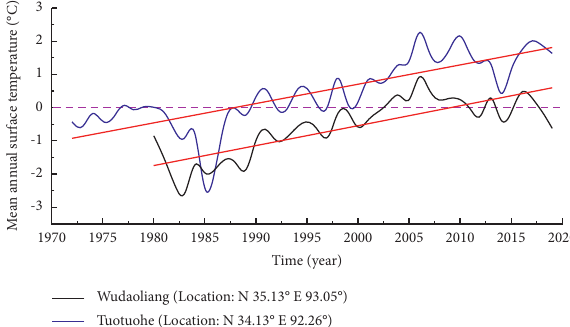
Figure 3: Variations of mean annual air temperature at national meteorological station within the QTEC from 1957 to 2019.